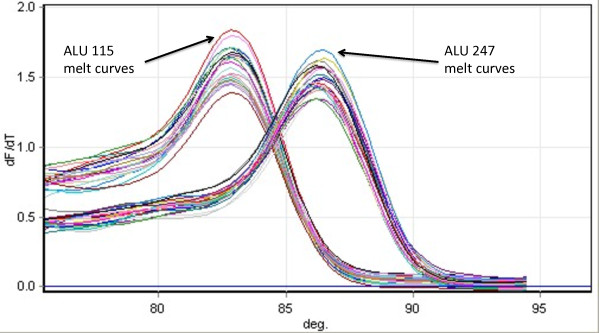
Melting curves of ALU 115bp and ALU 247bp amplifications signals from 20 patients. Following amplification, melting curves were obtained by calculating the derivatives dF/dT vs. temperature. ALU 115bp primers produce a peak of approximately 83°C and ALU 247bp at approximately 86°C.